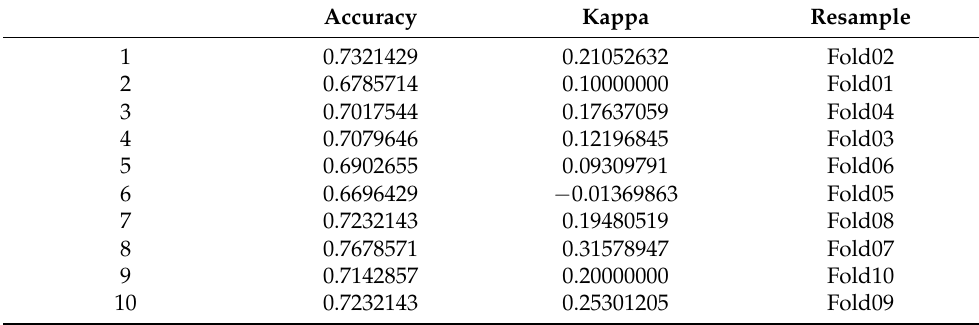
Table 3. Resampling results across tuning parameters using RF model. Accuracy was used to select the optimal model using the largest value. The final value used for the model was mtry =